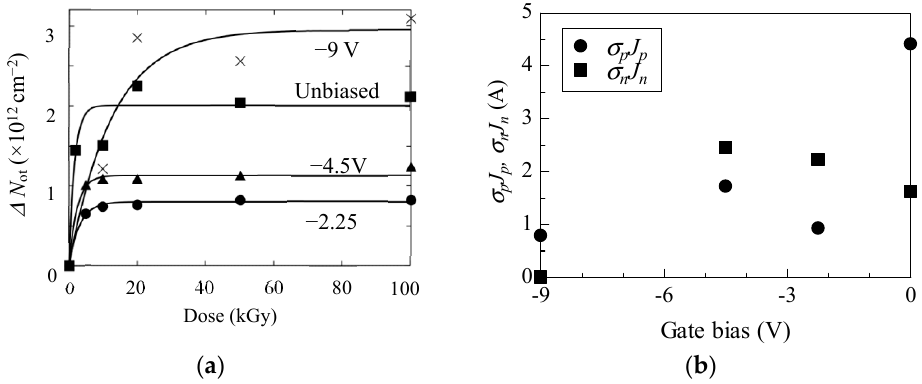
Figure 5. ( a ) Experimental plots and simulated curves for − 2.5, − 4.5 V, and non-biased samples plotted as a function of dose. ( b ) Estimated σ p J p and σ n J n plotted against applied gate bias during irradiation.